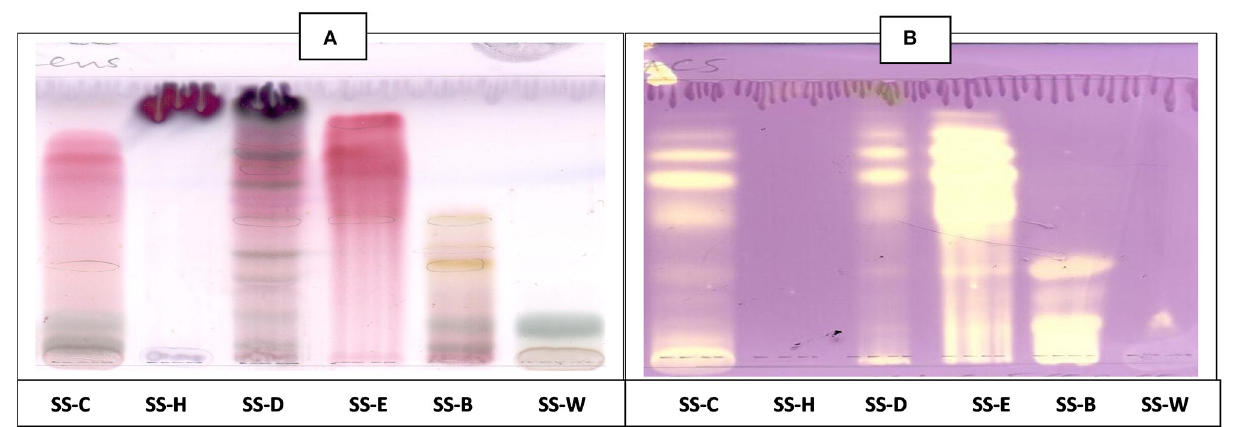
FIGURE 8 | (A) Chromatogram developed in EMW [ethyl acetate: methanol: water (40:5.4:4)] of S. singueana fractions sprayed with vanillin. (B) Antioxidant bioautography–TLC plate developed with EMW (40:5.4:4) and sprayed with DPPH. SS-C, S. singueana crude extract; SS-H, hexane fraction; SS-D, dichloromethane fraction; SS-E, ethyl acetate fraction; SS-B, butanol fraction; SS-W, Water.